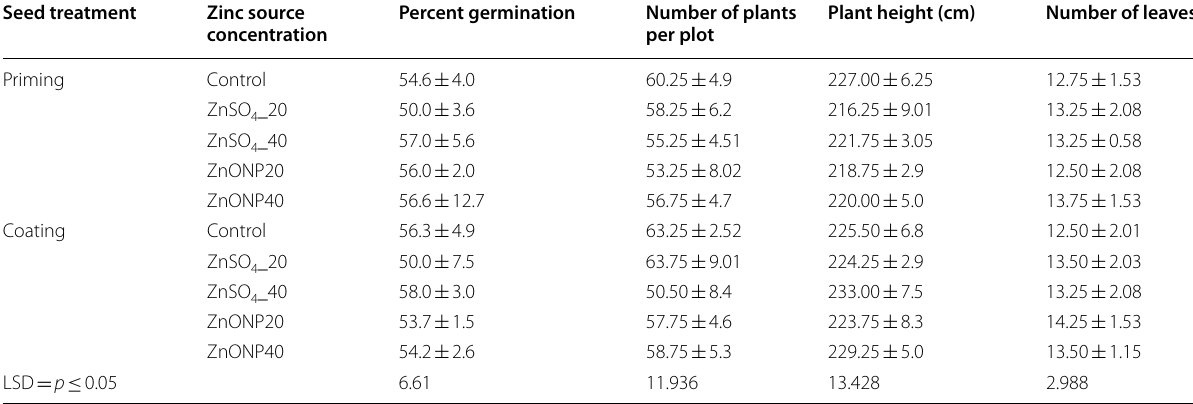
Table 1 Effect of seed treatments and various concentrations of Zn‑sources applied on vegetative growth parameters in maize var. PMH‑1 under field conditions